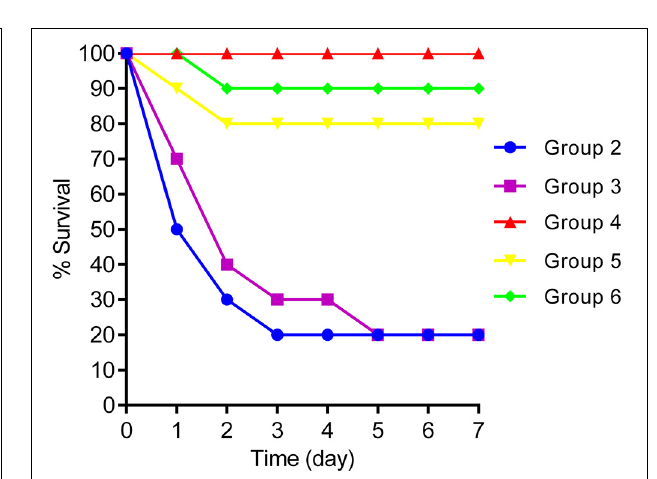
FIGURE 6 | Survival rates for groups 2, 3, 4, 5, and 6.